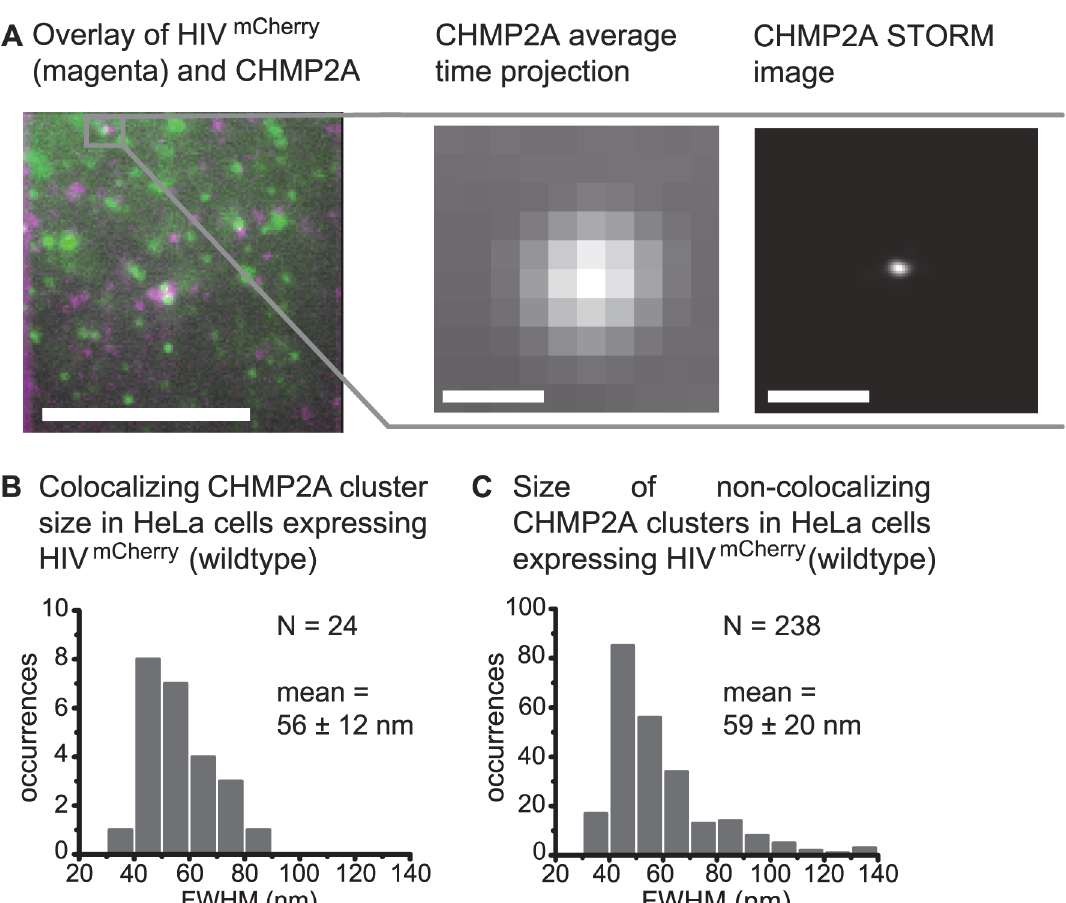
Fig 5. Super-resolution imaging of CHMP2A at HIV-1 assembly sites. HeLa cells were transfected with HIV:HIV mCherry and endogenous CHMP2A was detected by immunostaining 14 – 15 h post transfection. HeLa cells were imaged using TIRFM. ( A ) Left panel . A merged time-projected TIRF image of HIV mCherry (magenta) and CHMP2A (green) prior to STORM analysis. Middle panel . A zoomed-in image of the selected CHMP2A cluster highlighted in grey in the left panel colocalizing with an HIV assembly site. Right panel . The corresponding drift-corrected STORM image of the CHMP2A cluster. Scale bars: 500 nm. ( B ) The size distribution of all CHMP2A structures colocalizing with HIV mCherry with an average cluster size (FWHM) of 56 ± 12 nm. ( C ) Size distribution of all non-colocalizing CHMP2A clusters in cells co-expressing HIV mCherry with an average cluster size (FWHM) of 59 ± 20 nm.